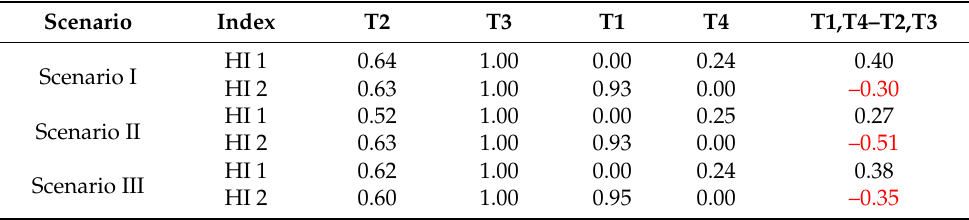
Table 4. Normalized HySpex indices applied to laboratory data of the averaging scenarios for trees 1–5 (see Table 3), where T2 and T3 are healthy and T1 and T4 are infested (green attack). T5 is not considered due to a different infestation level (brown crown). The last column shows the normalized distance between healthy (T2 and T3) and infested (T1 and T4) spruces. In context of the laboratory data, HI 1 shows a positive difference in all three scenarios. There is no overlap between healthy and infested spruces, so that a threshold value can be used for differentiation. In contrast, HI 2 has a negative difference (red numbers). Accordingly, HI 2 cannot differentiate between healthy and infested